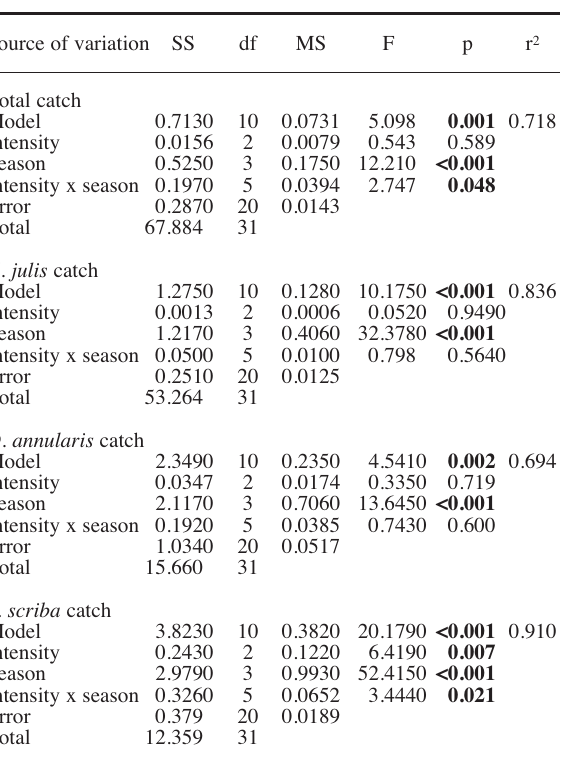
T ABLE 1. – Effects of the level of fishing intensity and season on the CPUE. Summary of the two-way ANOVAs. Mean and standard deviations values are shown in Figure 4. Bold type denote signifi- cance levels <0.05. SS: Sum of Squares; df: degrees of freedom; MS: Mean